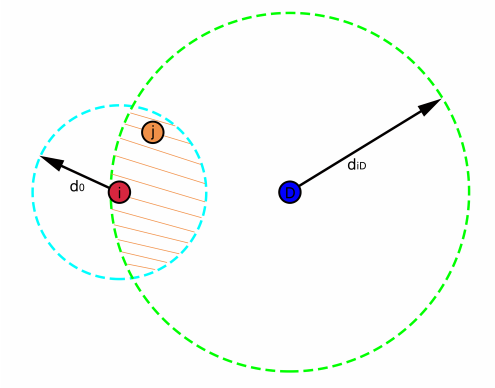
Figure 5. Forward transmission region.